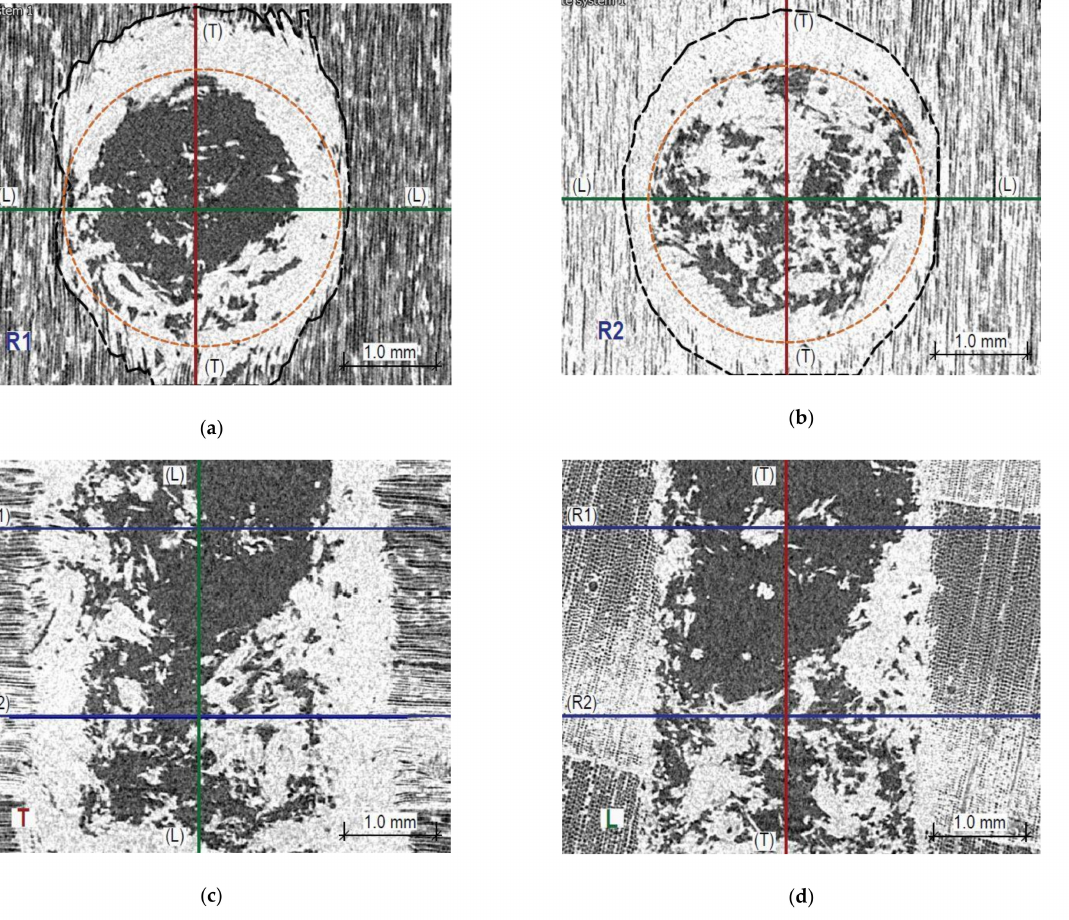
Figure 17. Sections through the opening after the resistance drilling test of the sample in the fibre. ( a ) the tangential wood surface is visible; ( b ) Cross-section within latewood R2—the tangential wood surface is visible; ( c ) Longitudinal section T—the radial wood surface is visible; ( d ) Longitudinal section L—wood cross-section is